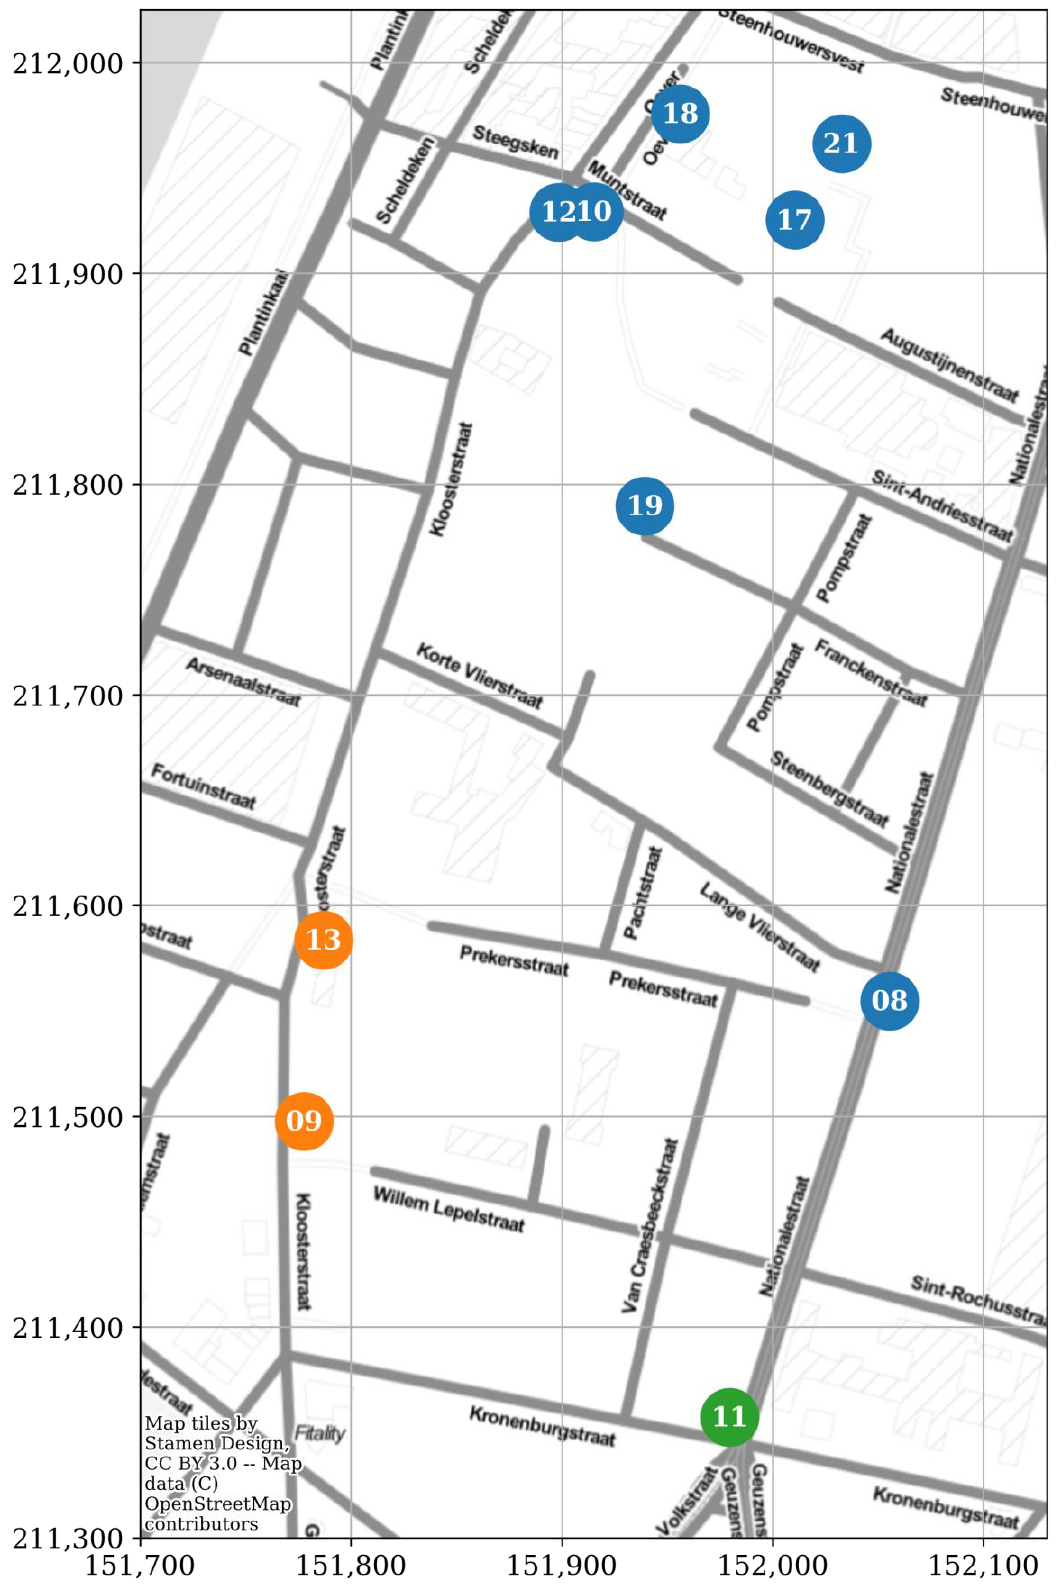
Figure 14. Clustering of the fixed RF-EMF sensors (labelled with their ID number) based on their temporal correlation (coordinate system: Lambert 1972).